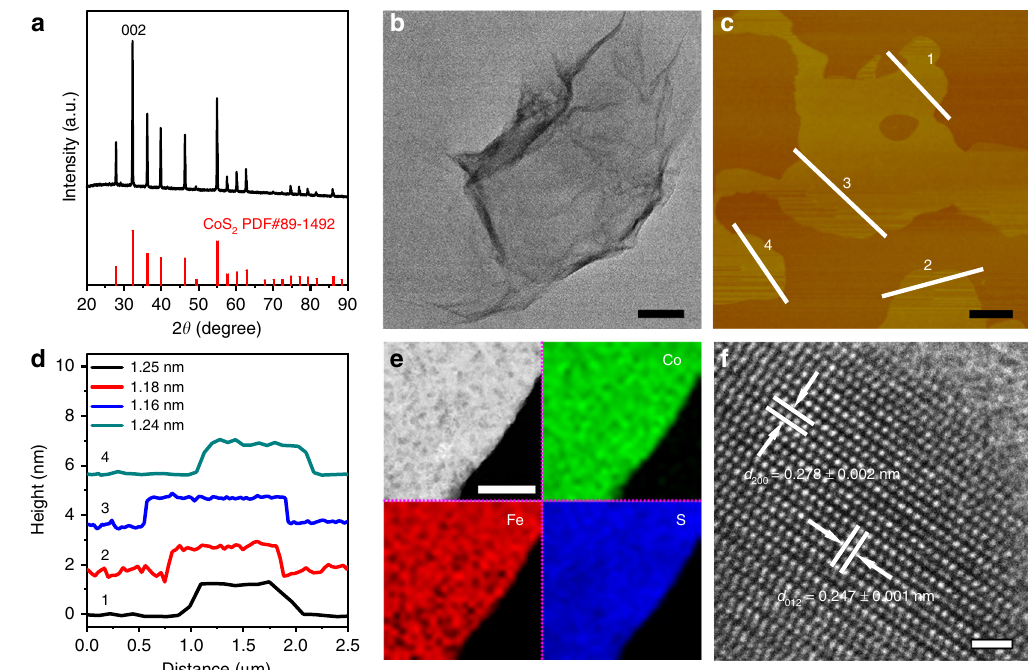
Fig. 1 Characterization of the Fe-CoS 2 nanosheets. a XRD pattern, in which the standard pattern of CoS 2 is added in red for comparison. b Low- magni fi cation TEM image. c AFM image. d Height pro fi les taken along the white lines of 1 – 4 in c . The thickness values measured by the pro fi les are labeled in d . e HAADF image and its corresponding EELS mapping results of Co, Fe, and S. f HRTEM image. Scale bars: b , 100 nm; c , 500 nm; e , 100 nm; f , 1